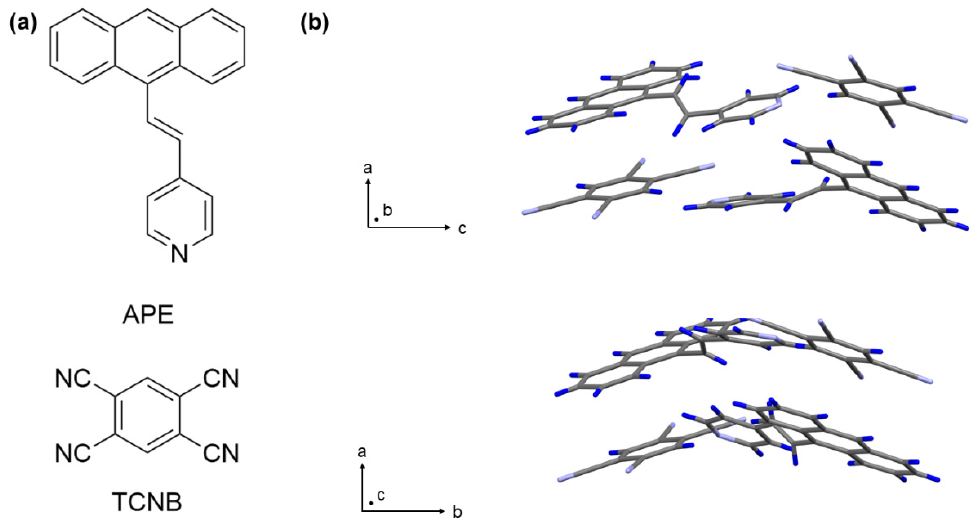
Figure 1. ( a ) Molecular structures used in this work; ( b ) crystal structure of APE-TCNB viewed along the crystallographic b -(up) and c -(down) axes.